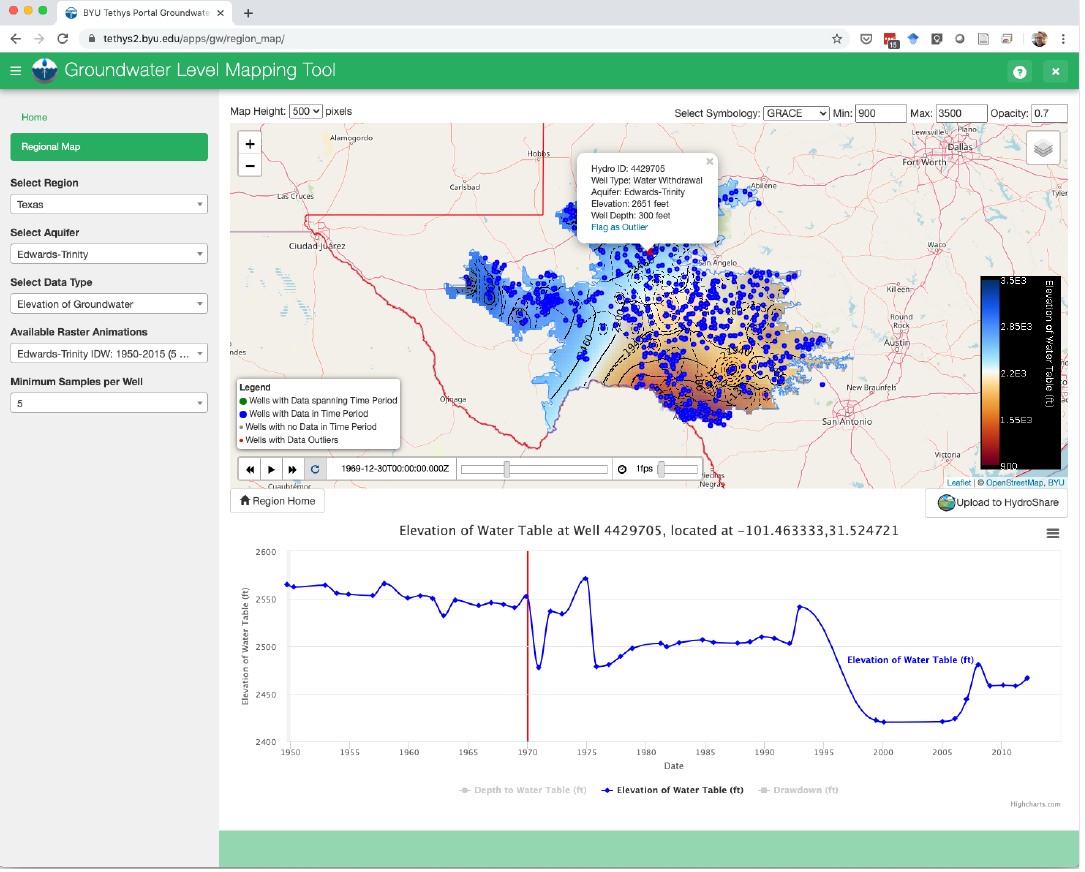
Figure 3. The user interface for the Groundwater Level Mapping Tool which was used to package the algorithms and methods described in this manuscript. This figure shows an aquifer in Texas along with the time history of water levels for a selected well.